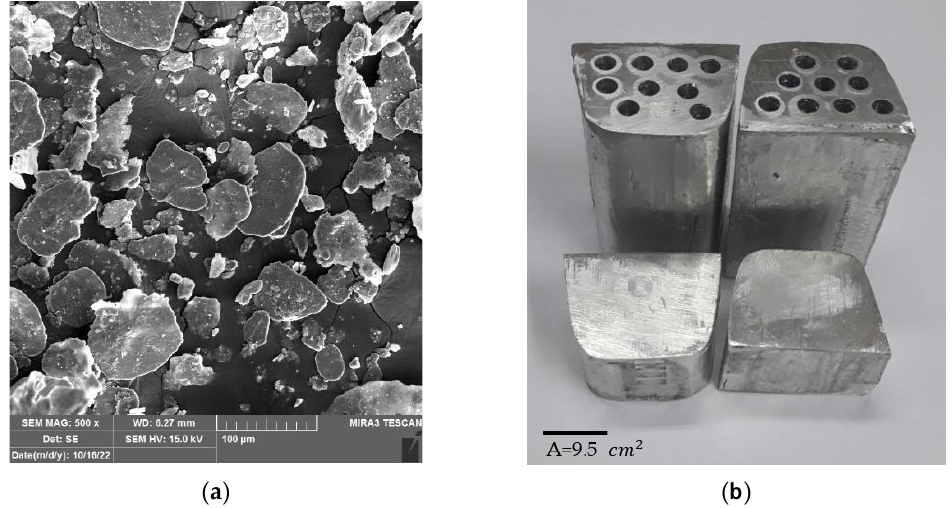
Figure 2. ( a ) Al – GNP composite powder produced by ball milling. ( b ) Drilled aluminum ingots before filling with Al – GNP ball-milled powder.